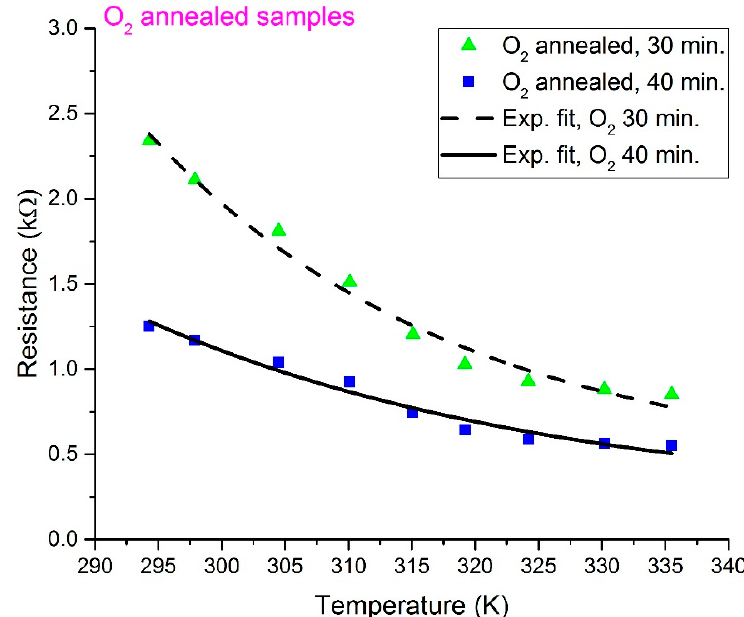
Figure 2. Measured resistance versus temperature for O 2 -annealed resistive thermometers.